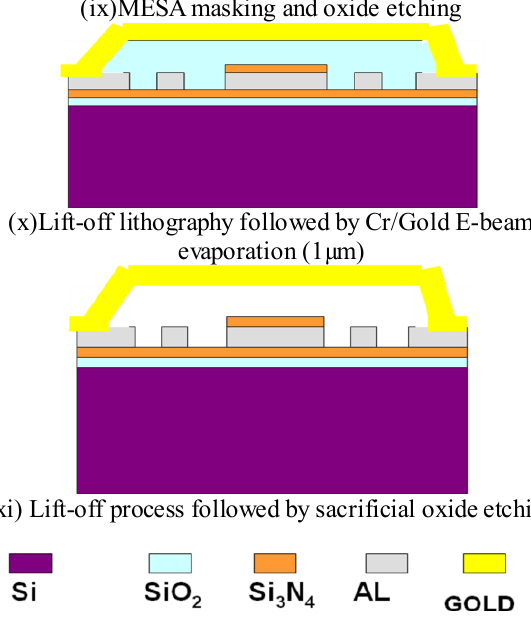
Figure 15: Proposed process flow for phased array